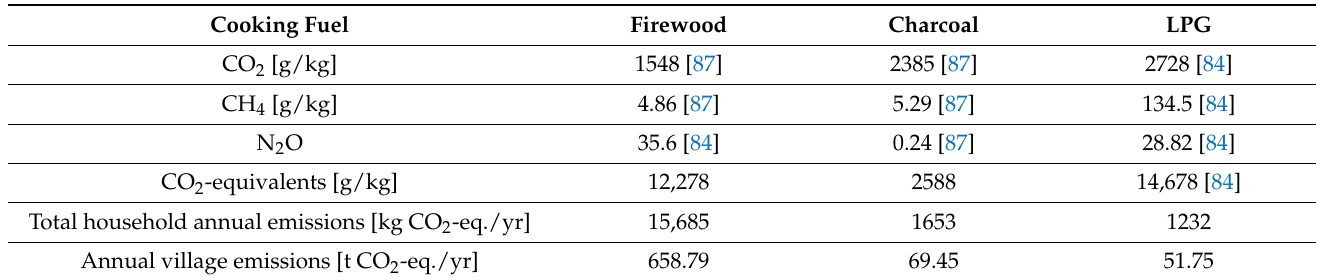
Table 7. Emissions occurring from the combustion of conventional cooking fuels. Factors for calculating the CO 2 -equivalents (100-year global warming potential factors are 25 and 298 for CH 4 and N 2 O, respectively